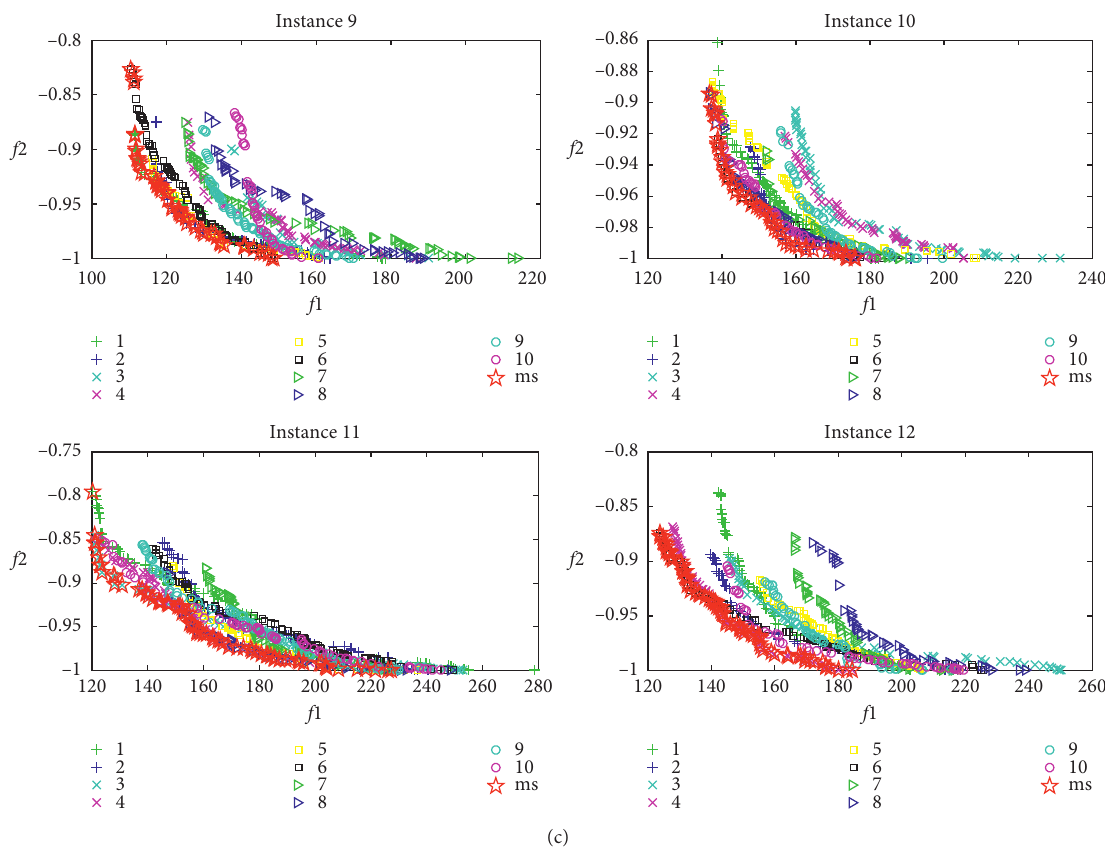
Figure 9: Computation results with or without multistart strategy. (a) Small-size instances. (b) Medium-size instances. (c) Large-size